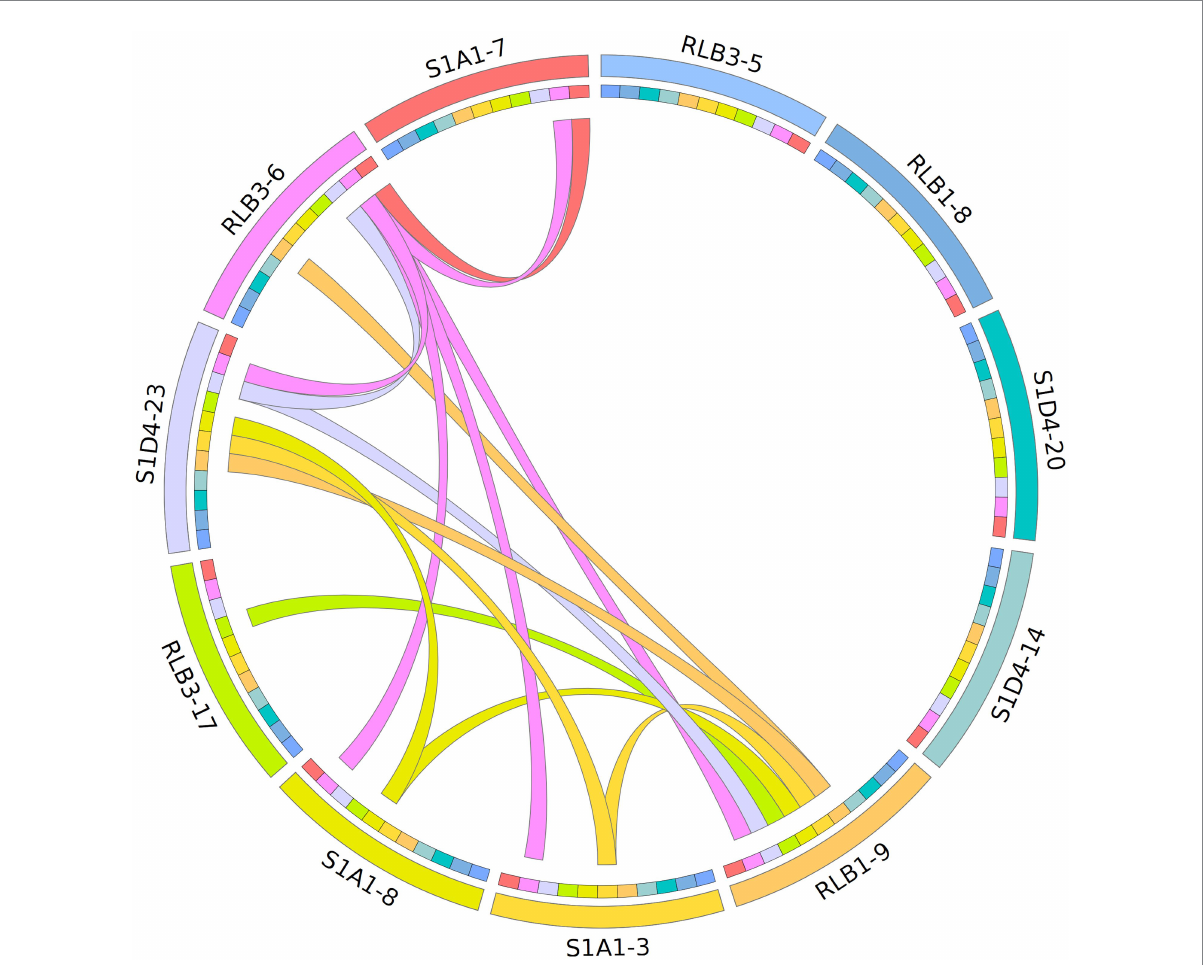
FIGURE 6 Mapping of AICE flux within the population based on a pock formation assay. Each of the 11 strain is represented by a colour (outer ring) and was tested as donor and recipient in bi-partite matings. The formation of pock is indicated by a link between two strains (interior ring). The colour of the link corresponds to that of the donor. The shades of colour symbolize clade affiliation as seen in Figure